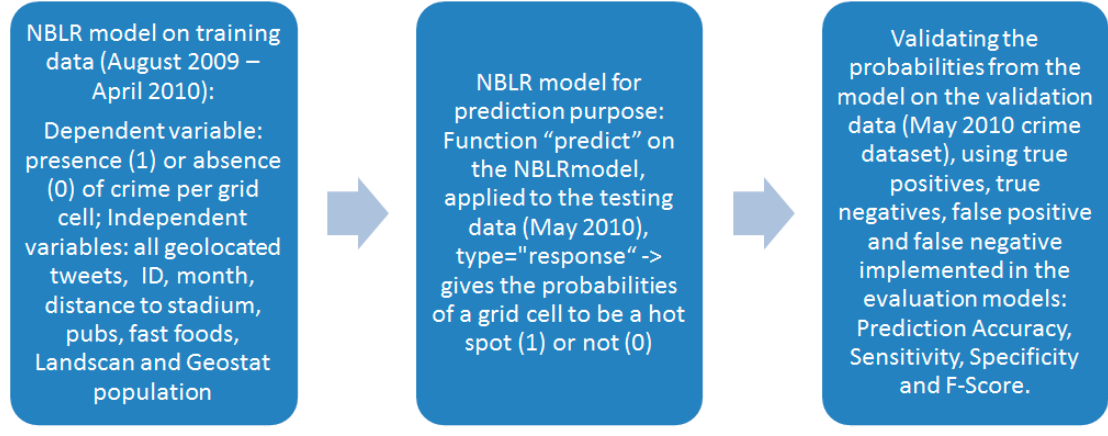
Figure 6. Example of negative binomial logistic regression (NBLR) usage for this study.